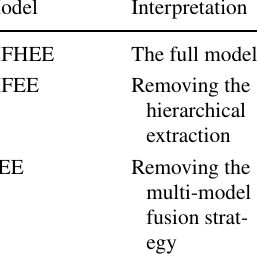
Table 5 Ablation models